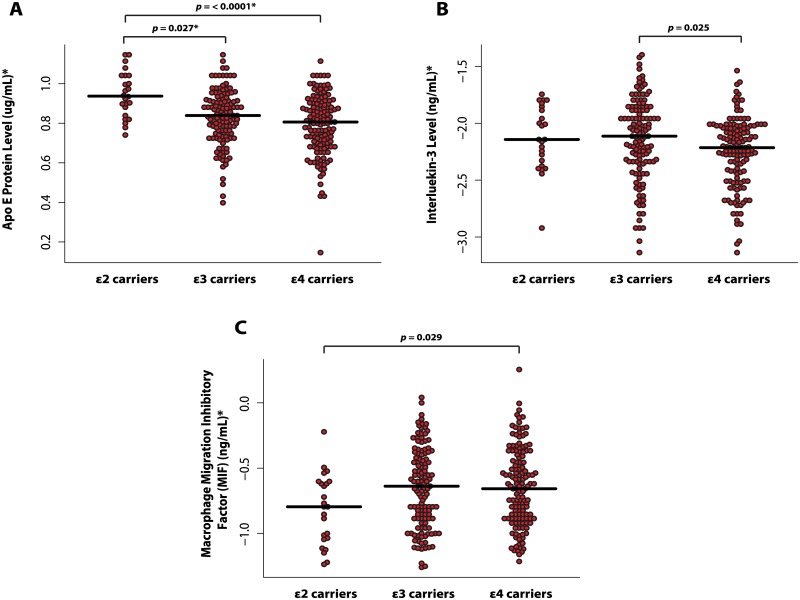
CSF proteins significantly associated with different ApoE gene polymorphisms (ε2 carriers, ε3 carriers, and ε4 carriers).
(A) CSF levels of ApoE protein between ApoE groups; (B) CSF levels of Interleukin-3 (IL-3) between ApoE groups and (C) CSF levels of Macrophage migration inhibitory factor (MIF) between ApoE groups. *These units refer to data before transformation.